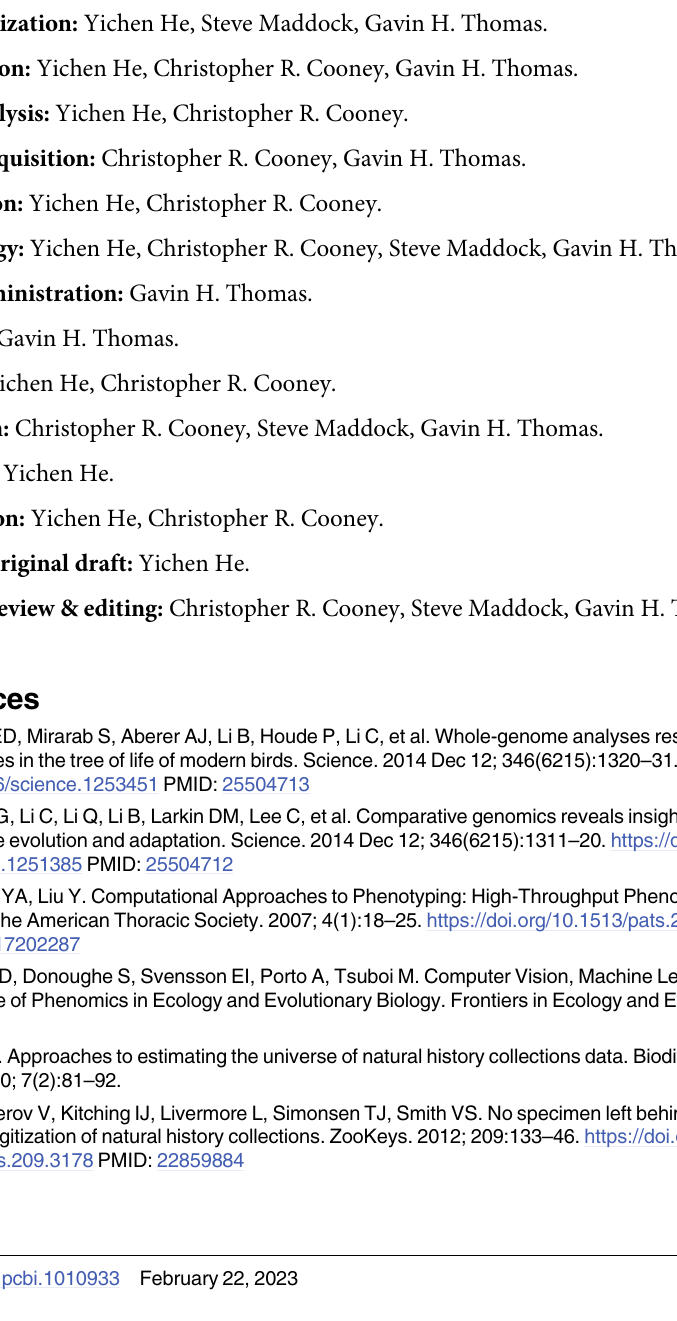
S8 Table. Group distances among the combinations of ecotypes and labelling methods.